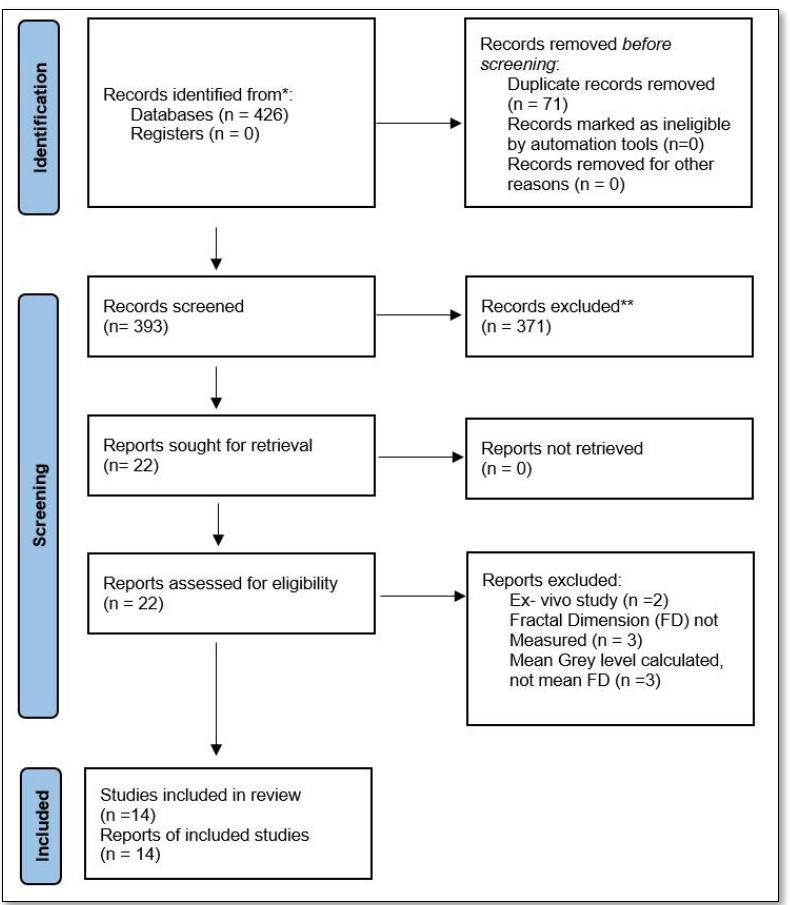
Figure 1. PRISMA flowchart depicting the identification of studies via databases and registers. * Records identified from MEDLINE, PubMed, Scopus and Web of Science databases. ** Records excluded by reviewer only. No automation tools were used.